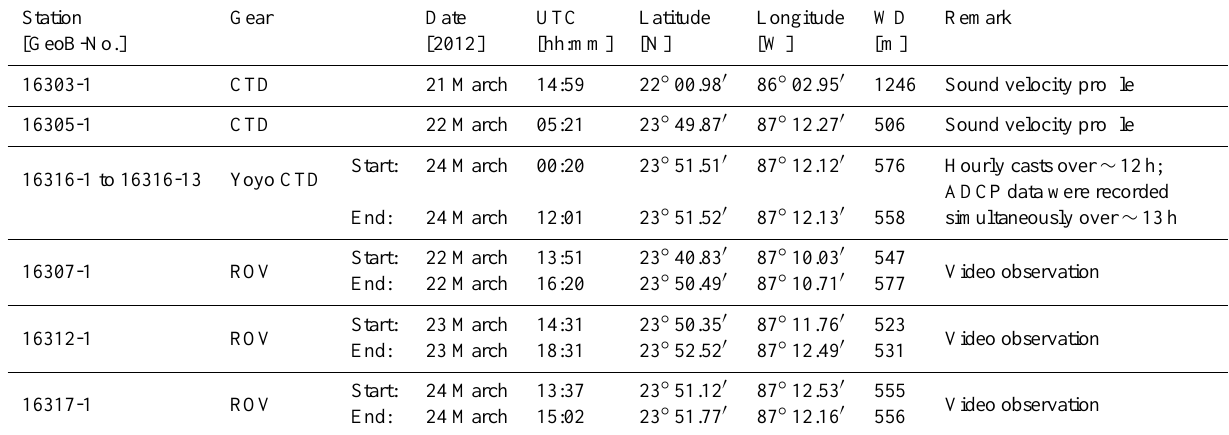
Table 1. Metadata of CTD casts and ROV Cherokee video surveys conducted at the Campeche cold-water coral province during R/V Maria S. Merian cruise MSM 20-4. Abbreviations: WD: water